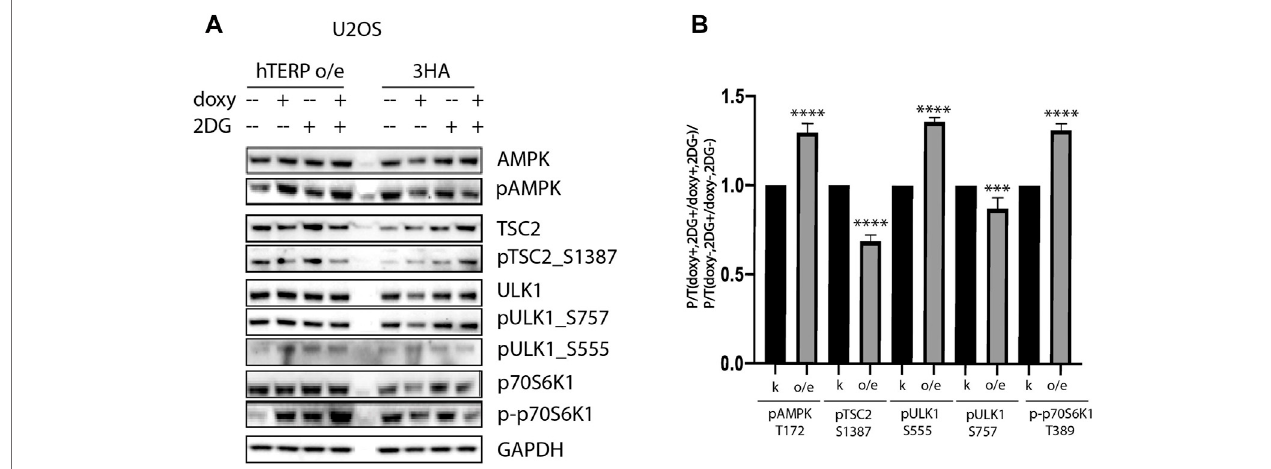
FIGURE4| hTERPmodulatesactivityofkinasesofrelevantsignaling pathwaysinU2OScells. (A) LysatespreparedfromU2OScellsexogenouslyexpressing3HA orhTERP-3HAtreatedwithorwithout2 mM2-DGwereprobedwiththeindicatedantibodies. (B) Quanti fi cationofphosphorylationlevelsoftheindicatedproteins.Black bars correspond to ratio of phosphorylated protein to total protein levels in overexpressing-3HA U2OS cells treated with doxycycline (doxy+), or 2-DG treated cells normalizedtotheratioforcellstreatedwithdoxycycline(2DG+/doxy+),cellsnottreatedwith2-DG(2DG − ).Greybarscorrespondtoratioofphosphorylatedprotein to total protein levels in overexpressing-hTERP cells treated with doxycycline (doxy+), or 2-DG treated cells normalized to the ratio for cells treated with doxycycline (2DG+/doxy+), or cells untreated with 2-DG (2DG − ). The same quanti fi cation was performed for the samples not treated with doxycycline (doxy − ), or treated with 2-DG relative to the ratio of cells not treated with doxycycline (2DG+/doxy − ), or cells not treated with 2-DG (2DG − ). Those normalized data were used for quanti fi cation of changes in the phosphorylation rate of targeted protein upon the exogenous expression of hTERP [(doxy+, 2DG+/doxy+, 2DG − )/(doxy − , 2DG+/doxy − , 2DG − )]. The ratio for cells treated with 2-DG was normalized to the ratio for untreated cells from three independent western blots (mean ± SEM) and quanti fi ed using GraphPad software. *** p < 0.001, and **** p < 0.0001 by Dunett ’ s multiple comparison test.